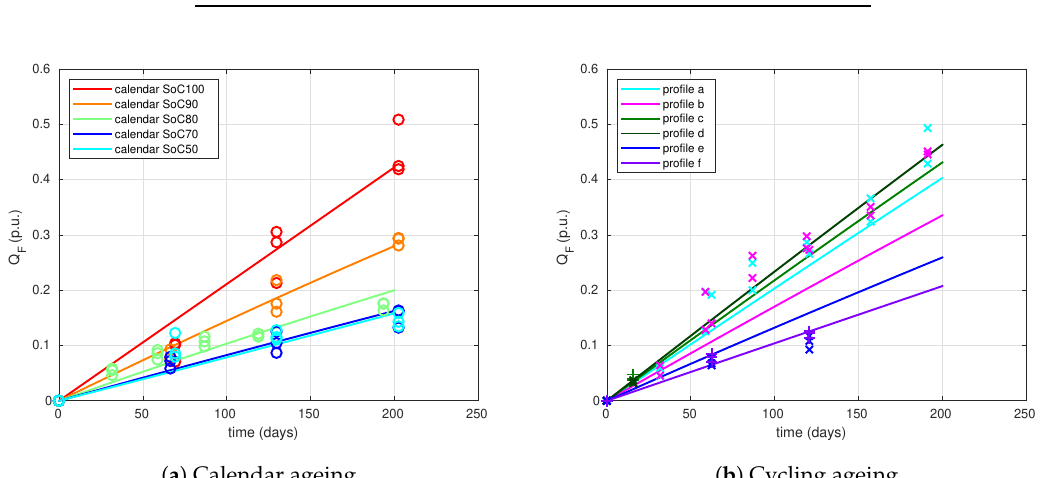
Figure 5. Capacity fade simulations compared to measurements under different ageing conditions. Simulations are plotted by using lines. Measurements are plotted with markers (the legend for these points is in Figure